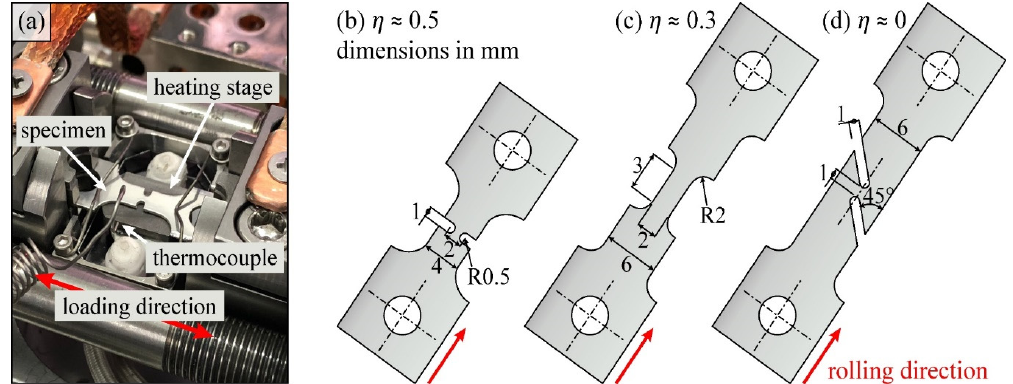
Figure 1. ( a ) Experimental setup for in-situ tensile tests inside the SEM, as well as specimen geometries in mm and their theoretical stress triaxiality 𝜂 for stress states of ( b ) high triaxiality, ( c ) simple tension, and ( d ) simple shear.